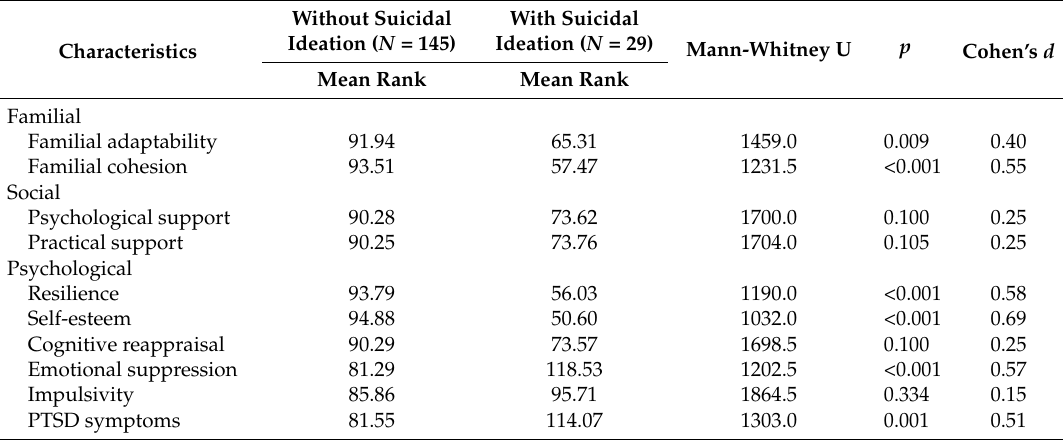
Table 2. Familial, social, and psychological characteristics of North Korean refugee youths with and without suicidal